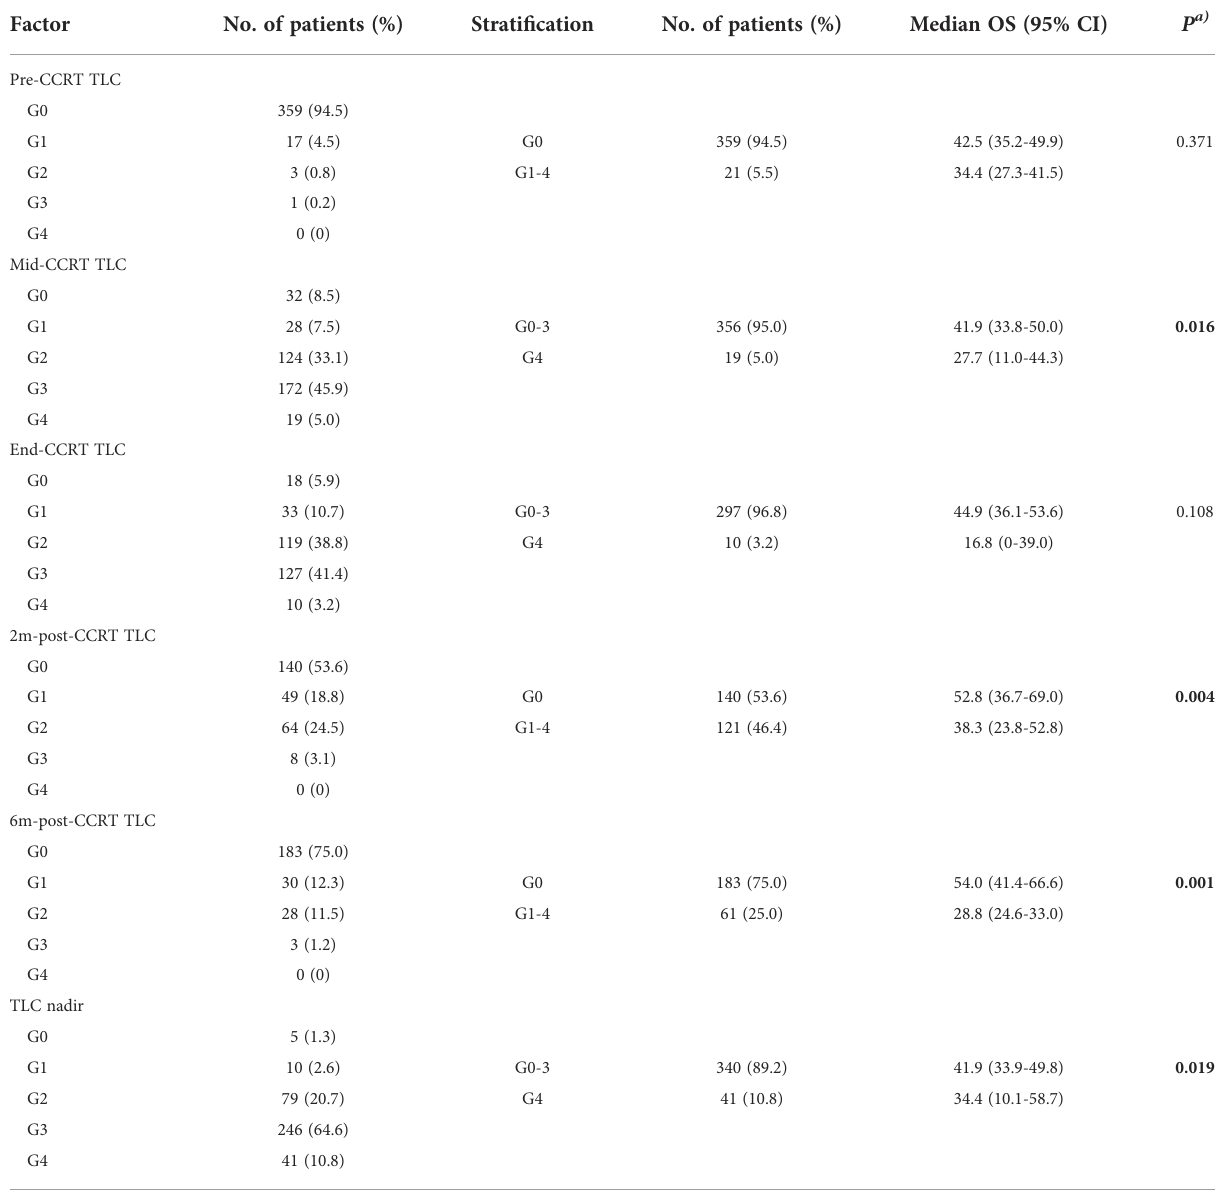
TABLE 2 The association between TLC and overall survival (OS). Factor No. of patients